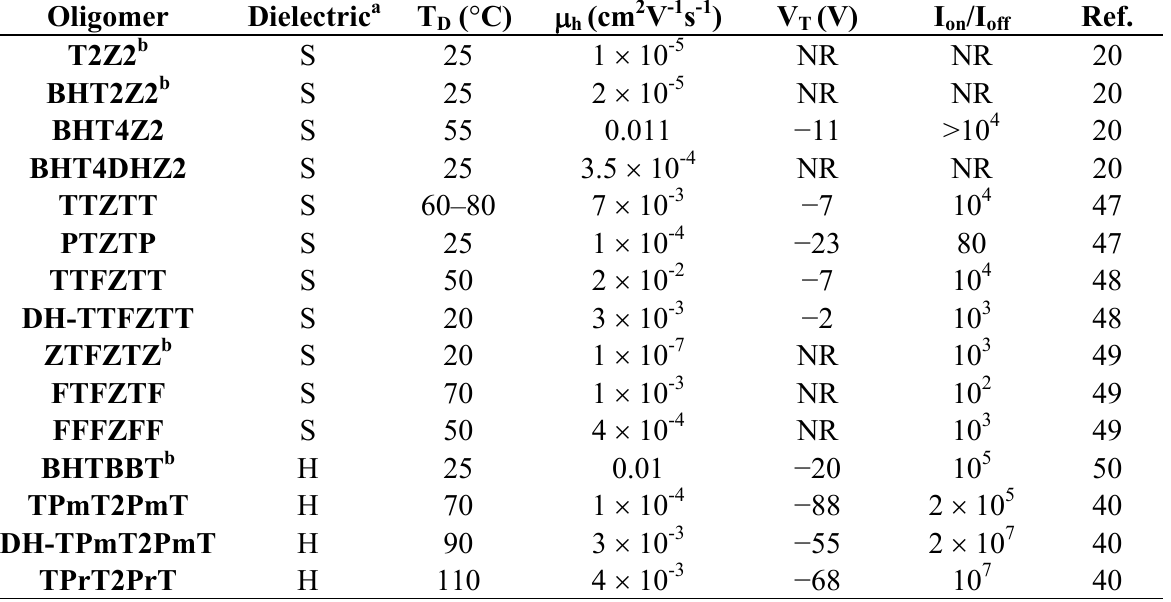
Table 1. Summary of the electrical performance (mobility, μ , current on/off ratio, I and threshold voltage, V ) of the of various azine- and azole-derived oligomers. Top- T contact device architectures are utilized unless otherwise